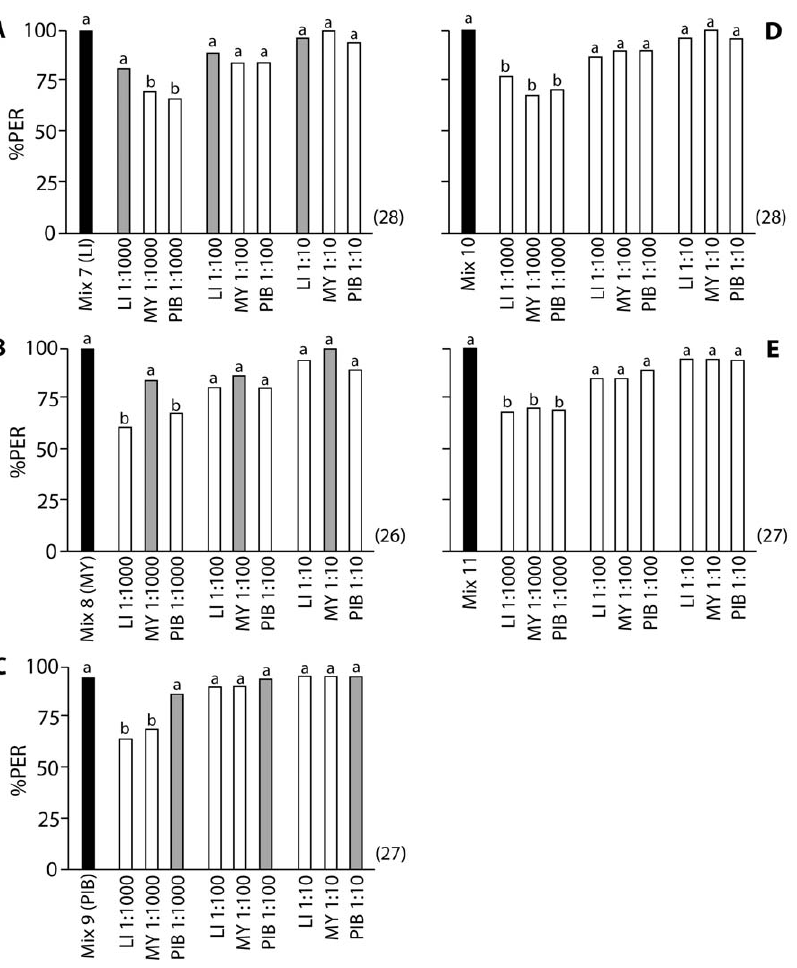
Figure 4. Effect of Odorant Concentration on Key Odorant Signatures. The ordinate represents the percentage of proboscis extensions (PER) to the training mixture (black bars), and to different concentrations of the individual test odorants that the mixture was composed of (grey and white bars). Training mixtures were composed of the same three odorants, but with one odorant at higher concentration than the other two. Grey bars indicate response to the odorant that was present at the high concentration in the respective training mixture. (A) Bees were trained to mixture 7, which contained LI at 1:10; (B) bees were trained to mixture 8, which contained MY at 1:10; (C) bees were trained to mixture 9, which contained PIB at 1:10; (D) bees were trained to control mixture 10, which contained all odorants at 1:100; (E) bees were trained to control mixture 11, which contained all odorants at 1:10. The numbers in brackets indicate the numbers of bees trained and tested in each experiment. Different letters above bars indicate significant differences between PER to the training mixture and to the individual odorants (McNemar test [2 6 2 Table], Bonferroni corrected threshold p , 0.0056). For mixture compositions see Table 6. Odorants are listed alphabetically by their abbreviations; for corresponding odorant names, see Table